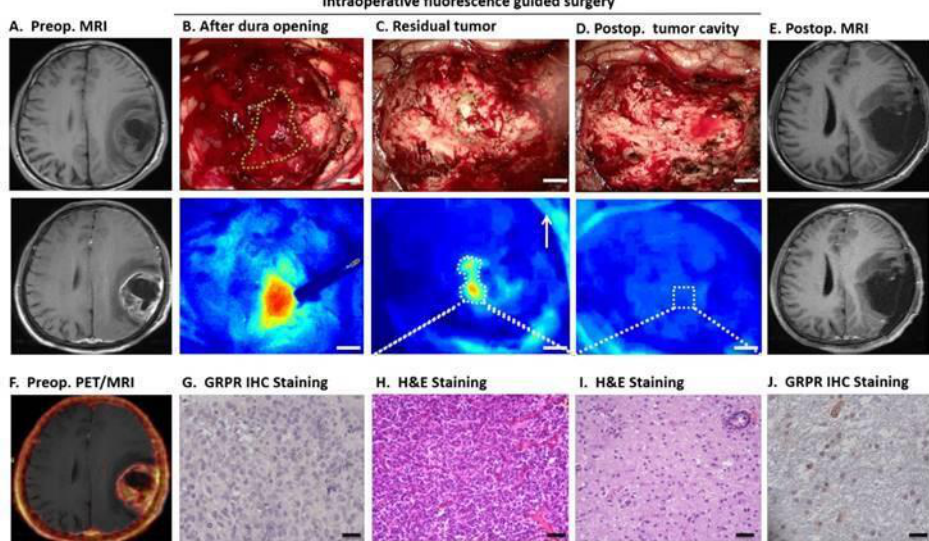
Figure 12. Dual-modal imaging for glioblastoma resection using 68 Ga-NOTA-IRDye800CW-bombesin. The glioblastoma tumour is visible by MRI after gadolinium injection. ( A ) Uptake in the tumour area was observed by PET/MRI, ( F ) The NIRF assessment displayed the fluorescent tumour (( B ): scale bar 5 mm). ( C ) Displays the fluorescent residual tumour tissue, and ( H ) the histological staining (scale bar 50 µ m). Several antigen-expressing cells were found in the tissue after gastrin-releasing peptide staining (( G ): scale bar 20 µ m). After resection, no residual fluorescence was detected in the tumour’s cavity. ( D ) Moreover, the tissue along the cavity was confirmed to be normal ( I ) and few antigen-expressing cells were found on it ( J ). The post-operative analysis shows total removal of the malignancy ( E ). Reprinted with permission from Ref. [79]. Copyright 2018